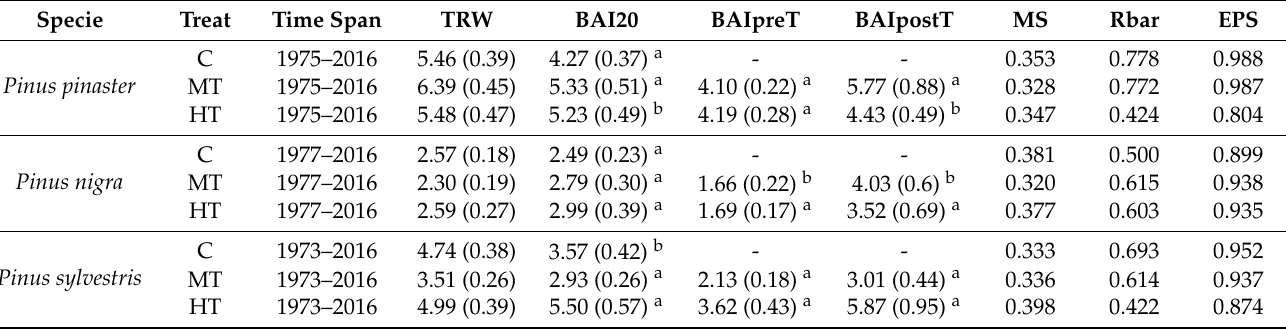
Table 3. Dendrochronological statistics of sampled Pinus pinaster , Pinus nigra and Pinus sylvestris for the three treatments (C, control or unthinned plots; MT, moderate thinning; HT, heavy thinning). TRW: mean tree-ring width; BAI20: mean basal area increment over the last 20 years; BAIpreT: mean basal area increment before thinning year; BAIpostT: mean basal area increment after thinning year (all in mm); MS: mean sensitivity; Rbar, mean among trees correlation; EPS, expressed population signal. Values are the means ± standard errors (in brackets), and superscripts (a, b) indicate when pairwise comparisons were significantly different. The hyphen symbol indicates no thinning treatment in the control plots.